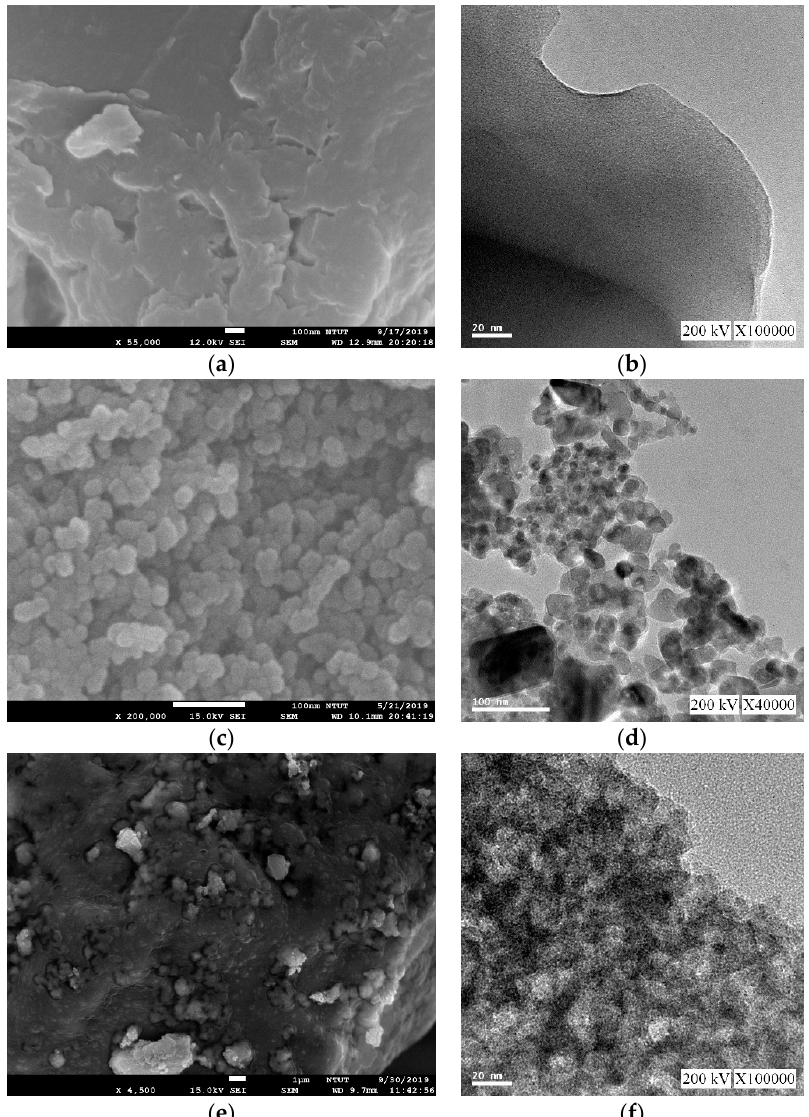
Figure 2. FESEM ( a ) and TEM ( b ) of SCN; FESEM ( c ) and TEM ( d ) of CoFe 2 O 4 ; FESEM ( e ) and TEM ( f ) of SCN/CoFe 2 O 4 .